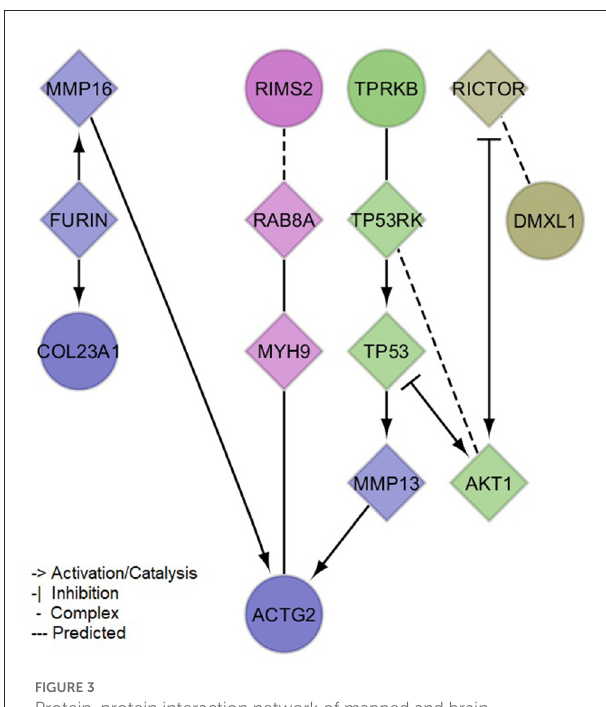
FIGURE3 Protein-protein interaction network of mapped and brain expression quantitative trail loci genes implicated by the identified (meta-analysis) suggestive loci for serum neurofilament light chain. Circles denote input genes. Diamonds denote linker proteins. Colors denote network clusters, whose enrichments for pathways and gene ontology cellular compartments can be found in the Supplementary material 2, Supplementary Tables 4,